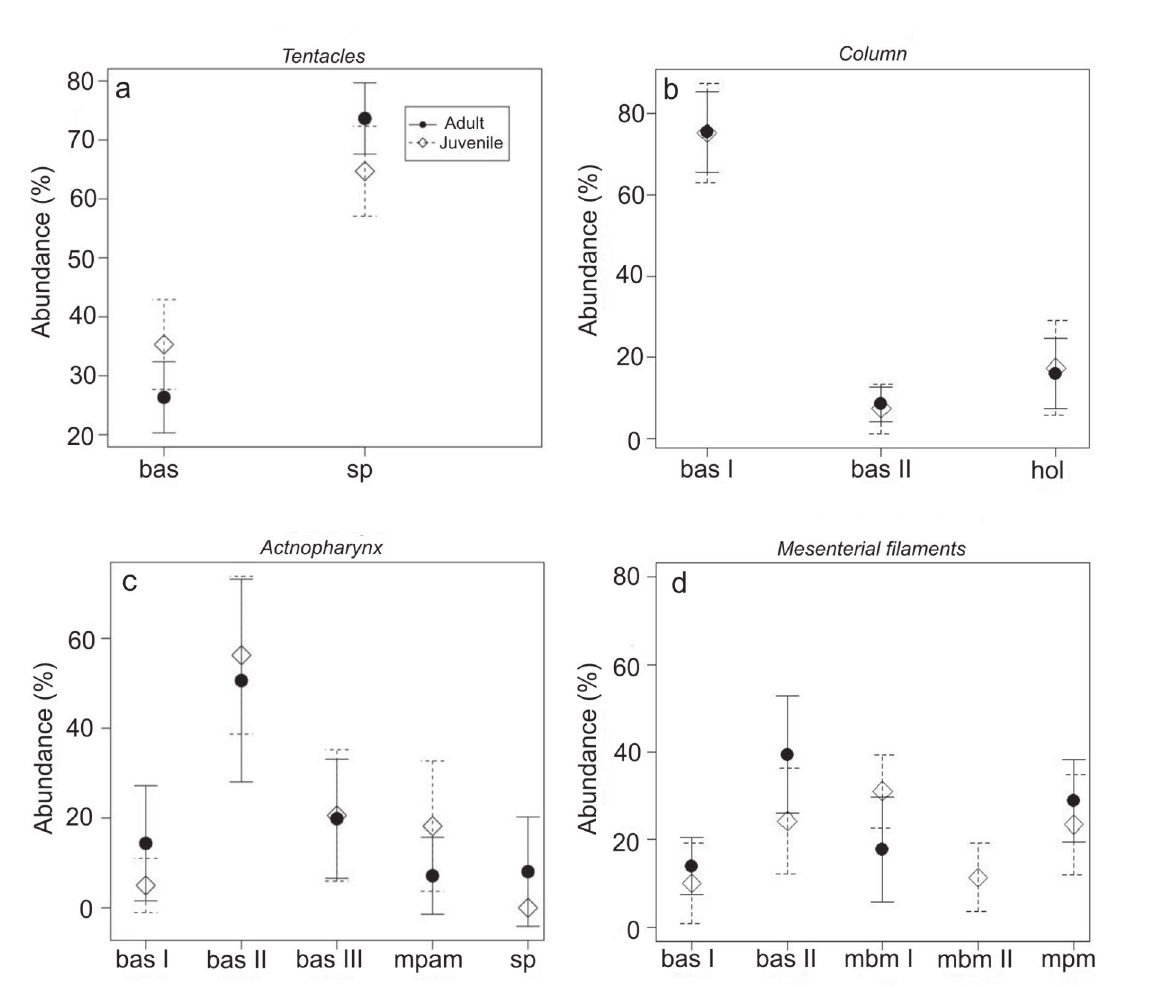
Figure 1 - Mean of abundance of cnida types in juvenile and adults of Aulactinia marplatensis . Basitrich (bas), spirocyst (sp), holotrich (hol), microbasic p -amastigophore (mpam), microbasic b -mastigophore (mbm), microbasic p -mastigophore